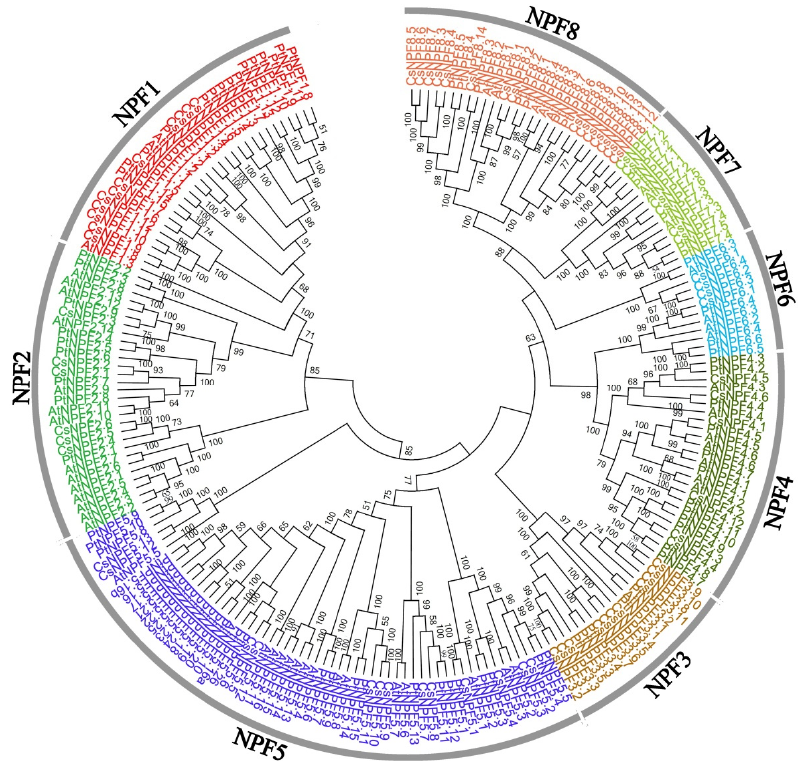
Figure 1. Phylogenetic tree analysis of NPF proteins from C. sinensis , A. thaliana , and P. Trichocarpa.